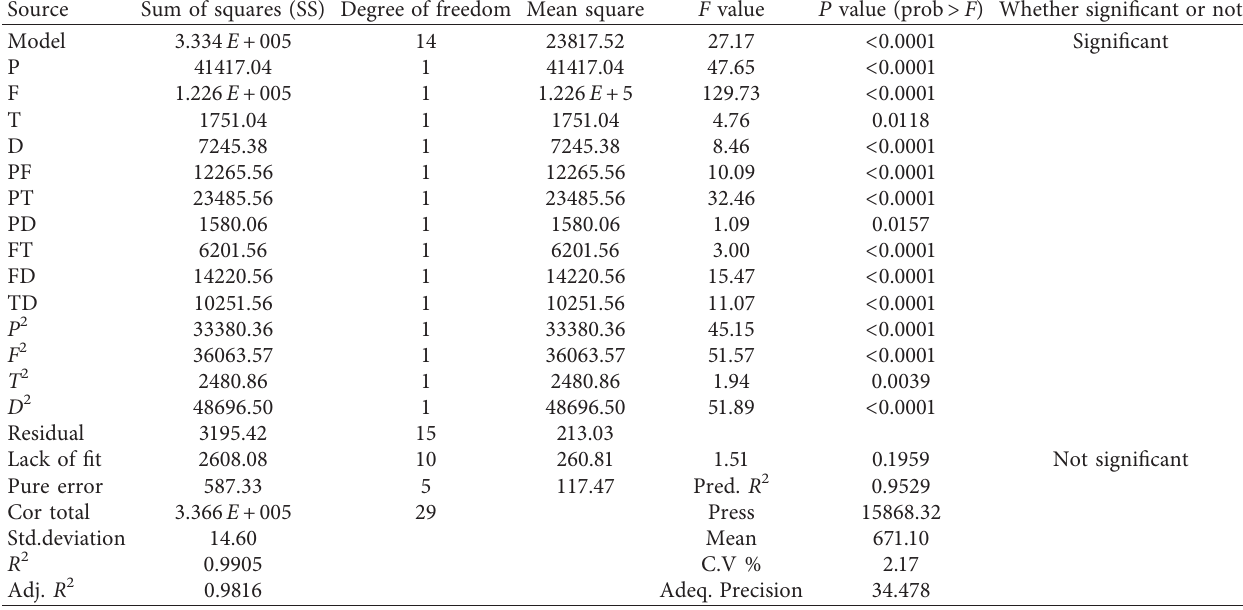
Table 4: ANOVA test results for microhardness of the deposit.